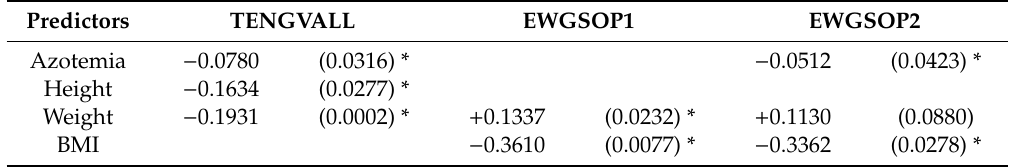
Table 4. The results of logistic regression for risk factors associated with low ASMI among females. Predictors